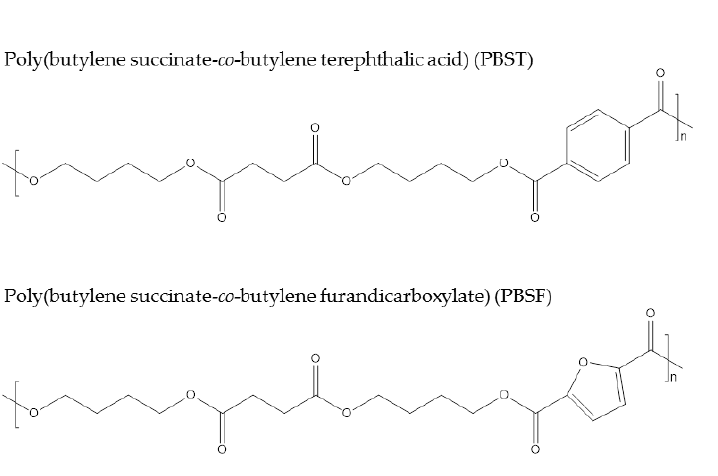
Figure 5. Chemical structures of succinate polymers.